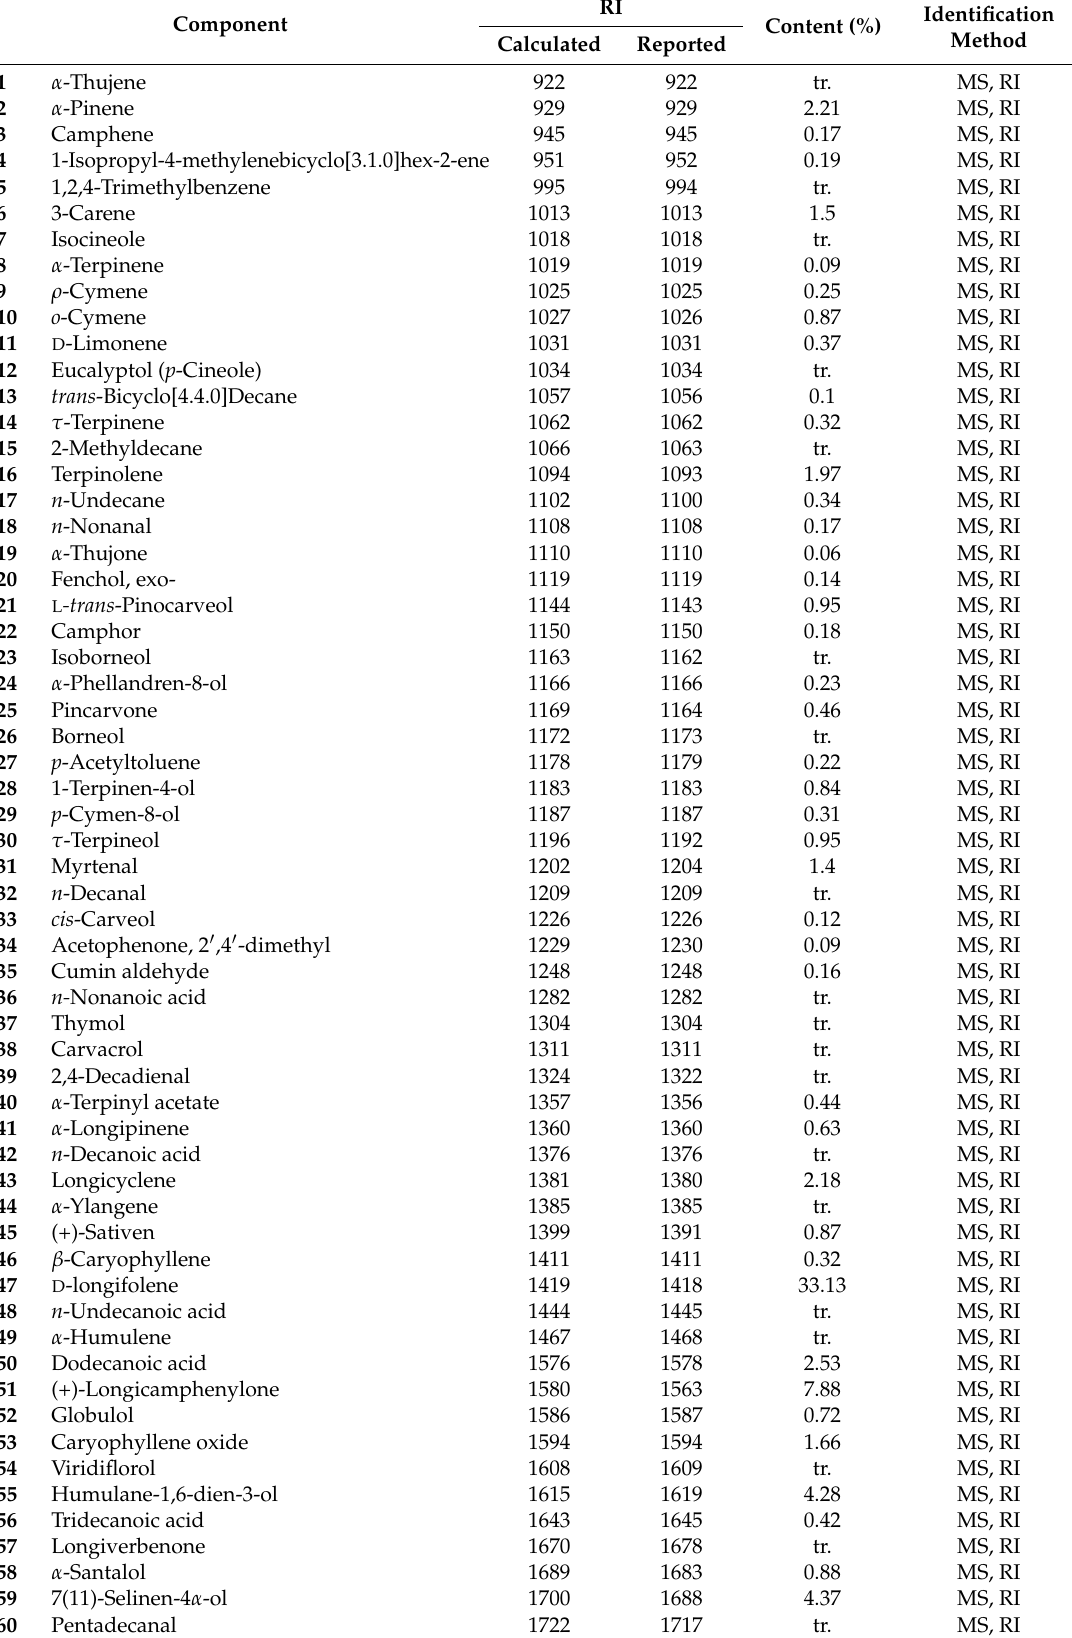
Table 1. Volatile constituents identified in Pinus roxburghii bark essential oil